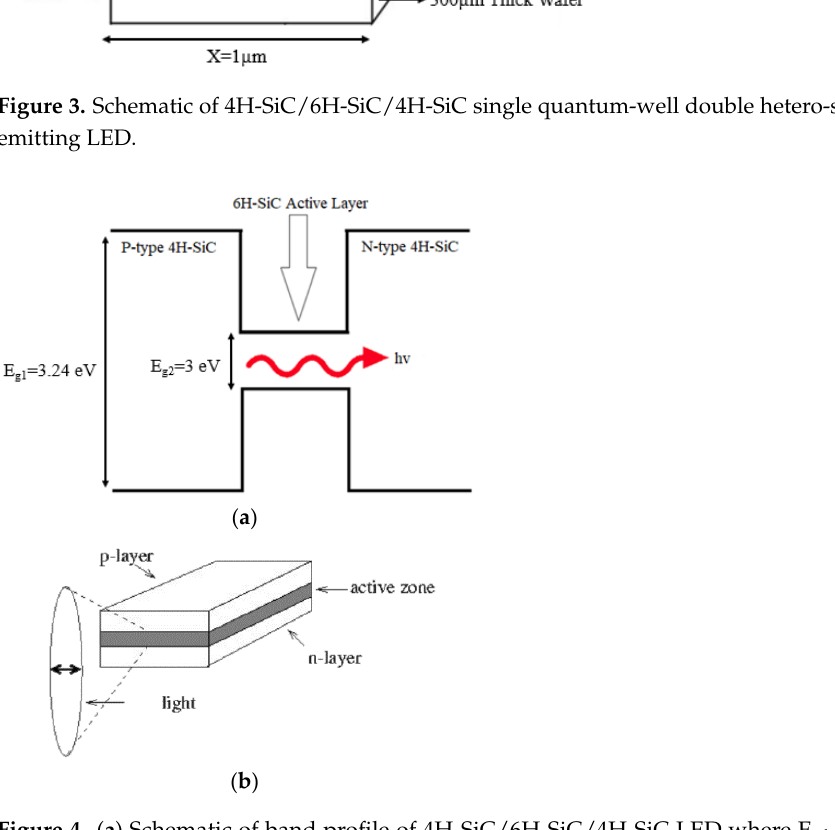
Figure 4. ( a ) Schematic of band profile of 4H-SiC/6H-SiC/4H-SiC LED where E g1 is bandgap of 4H-SiC and E g2 is bandgap of 6H-SiC; ( b ) emission of light from active layer region of edge-emitting LED.